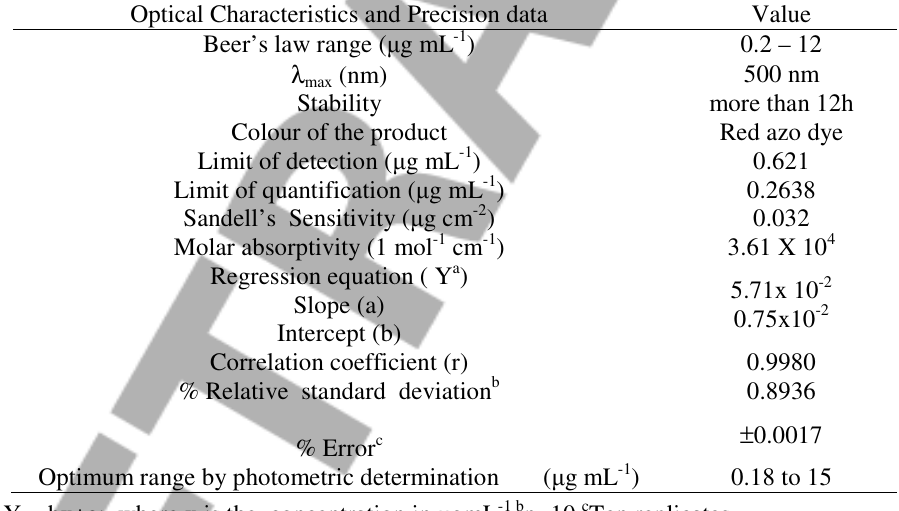
Table 1 Optical characteristics and precision data of mosapride Optical Characteristics and Precision